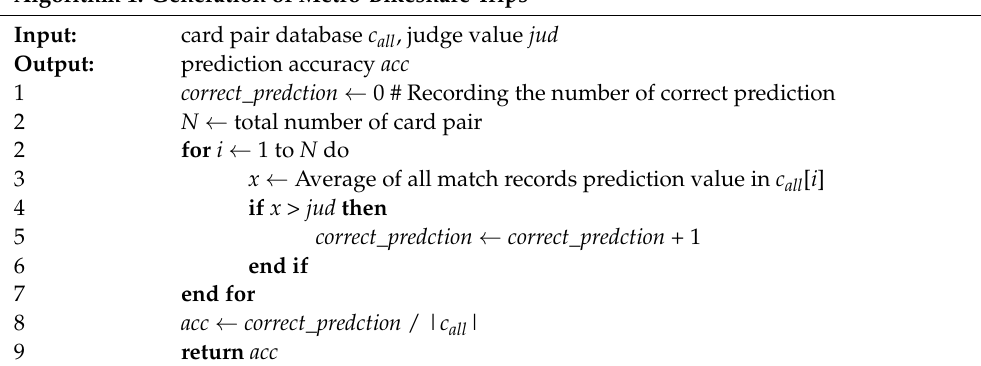
Algorithm 1: Generation of Metro-Bikeshare